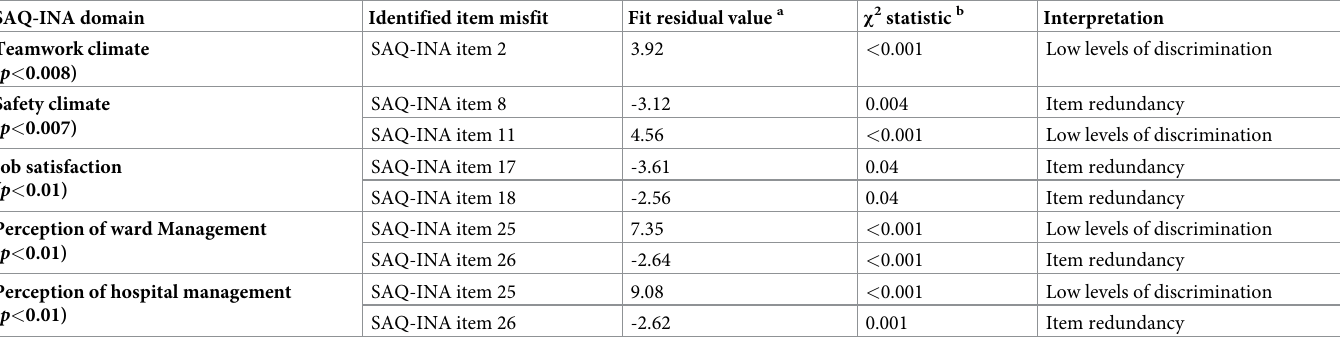
Table 3. Individual item misfit in each the SAQ-INA